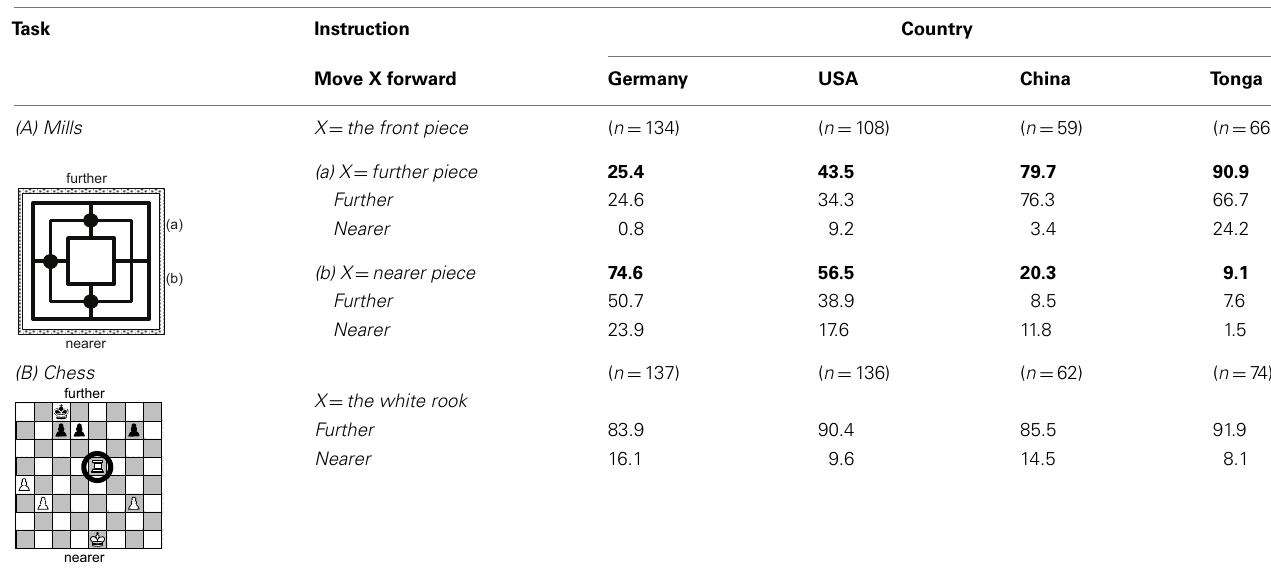
Table 4 | Percentages of individuals choosing the further/nearer piece as “the front piece” in the Mills task [(A), bold-faced], and percentages of individuals moving the chosen piece further away from or nearer toward them [(A) Mills and (B)